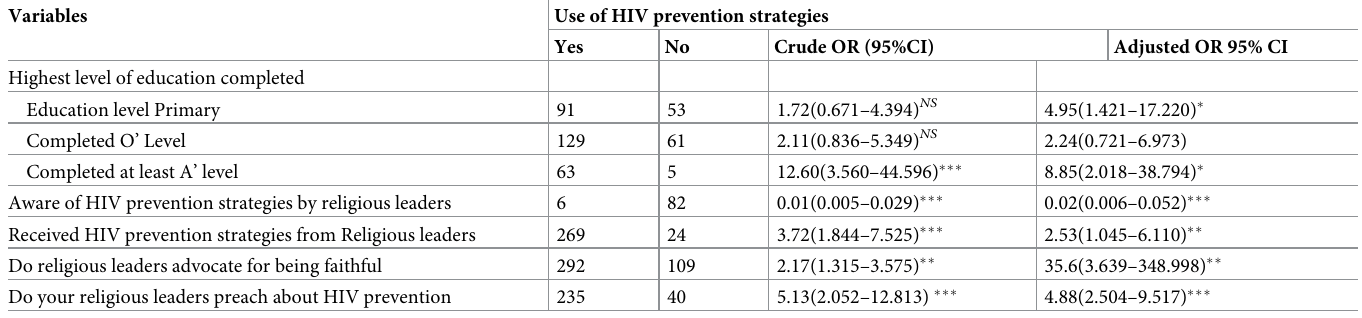
Table 3. Bivariate and multivariable logistic regression of factors associated with use of HIV prevention strategies among young